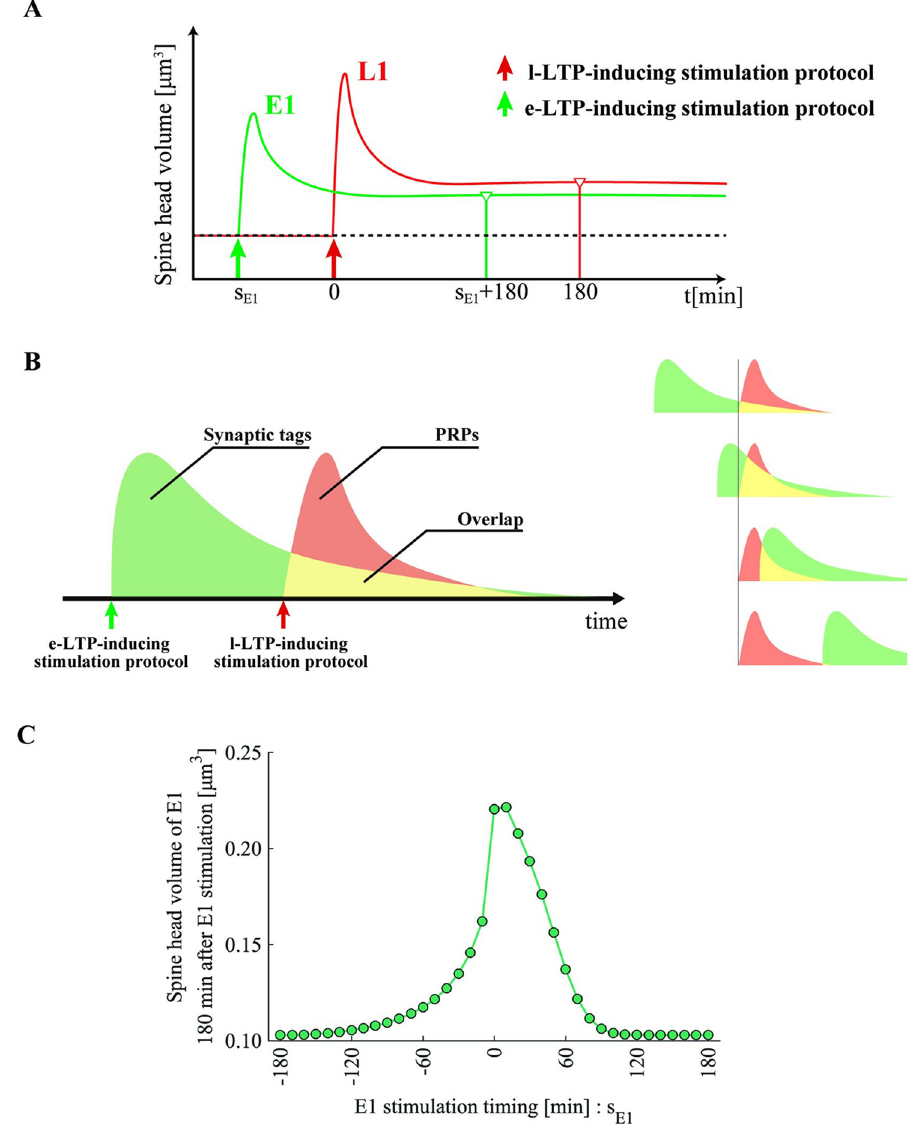
Fig 6. Temporal asymmetry of the STC window simulated by our model. (A) The schematic diagram of our experiment for simulating the temporal STC window. (B) Schematic illustration showing that the asymmetry of the STC temporal window is attributable to the difference in the time constants of the synaptic tag and newly synthesized PRPs. Yellow areas indicate the coexistence of synaptic tags and newly synthesized PRPs. The number of PRPs captured by synapses increases as the area increases. (C) A simulation result. Our model correctly simulated the asymmetry of the STC temporal window [12]. The horizontal axis denotes the relative timing of the e-LTP–inducing stimulation protocol at synapse E1 from the l-LTP–inducing stimulation protocol at synapse L1. The vertical axis denotes the spine head volume of E1 180 min after the e-LTP–inducing stimulation protocol to E1. asynchronous stimulation patterns were characterized by stimulation timing to synapse E1 s E1 and stimulation interval ds (Fig 8A). We varied the stimulation interval in the range of ds = E E [1,5,10] min and the basal PRP level of m = 1 × 10 − 4 –1 × 10 0 with +0.2 increments of the P d exponent.